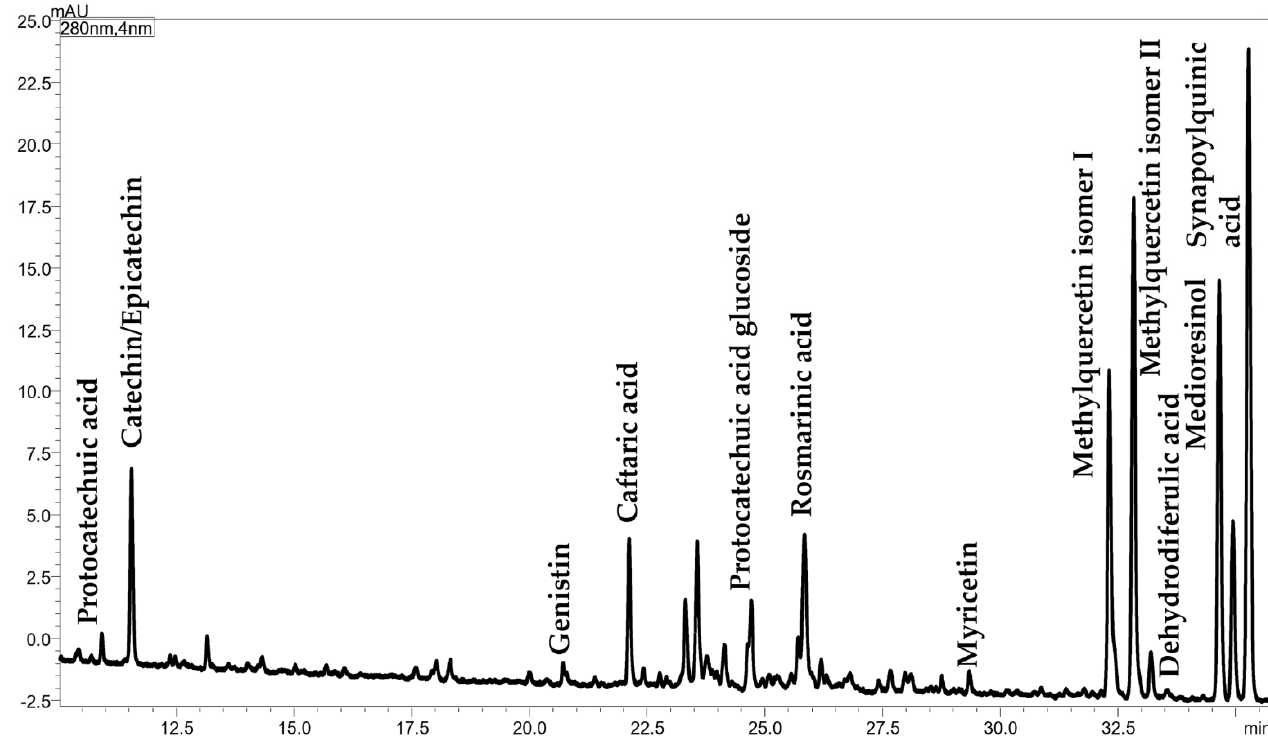
Figure 4. Expansion of the RP-LC-ESI( - )-qMS chromatogram of polyphenols in Chia seed oil.